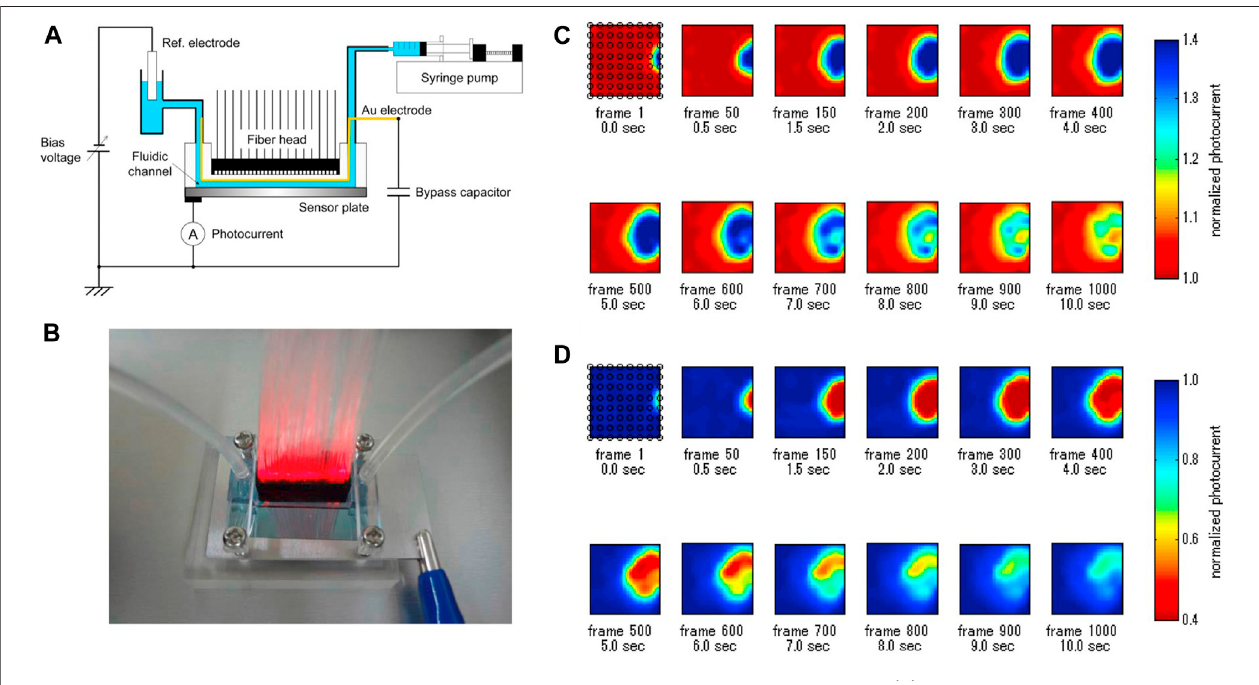
FIGURE4|(A) SchematicdiagramoftheU-shapedmicrochannelLAPSanalysissystemwithatrapstructure; (B) Distributionofenzymaticreactionimagesofurea solution in microchannels under different urease injection fl ow rates, 0.1 ml/h, 0.5 ml/h, and 1 ml/h (Miyamoto et al., 2011).